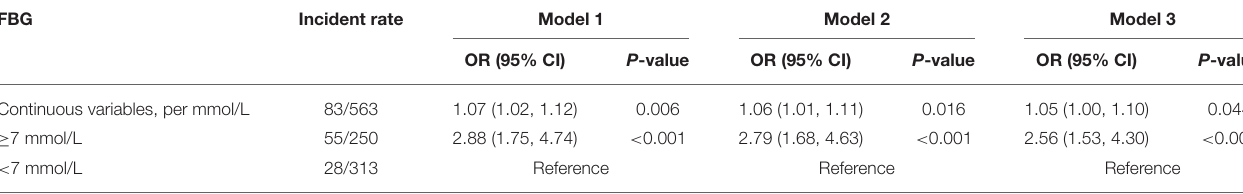
TABLE 3 | Association between fasting blood glucose and new onset atrial fibrillation.